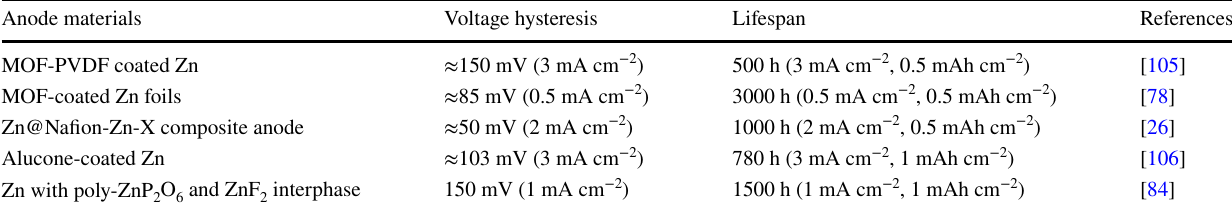
Table 4 Summary of recently reported coatings modification strategies for composite materials Anode